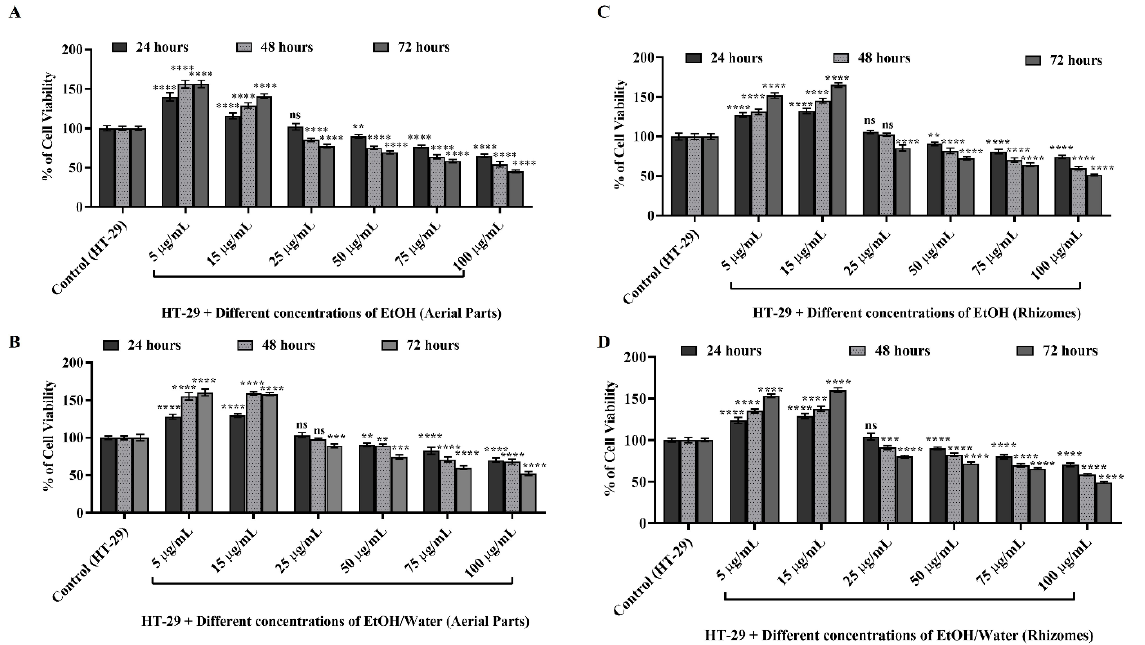
Figure 4. Determination of nontoxic concentration and % cell viability of EtOH and EtOH/water extracts from aerial and root parts of Primula auriculata in HT-29 colorectal cancer cell line with WST-1. Increasing concentrations (5–100 µg/mL) of EtOH aerial parts in ( A ), EtOH/water aerial parts in ( B ), EtOH rhizomes in ( C ), and EtOH/water rhizomes in ( D ) extracts were used to treat the HT-29 cell line for 24, 48, and 72 h, respectively. GraphPad Prism version 8 was used for statistical analysis, and the nonsignificant value was symbolized with ns. ** was used for p ≤ 0.01, *** was used for p ≤ 0.001, and p ≤ 0.0001 was shown with ****.